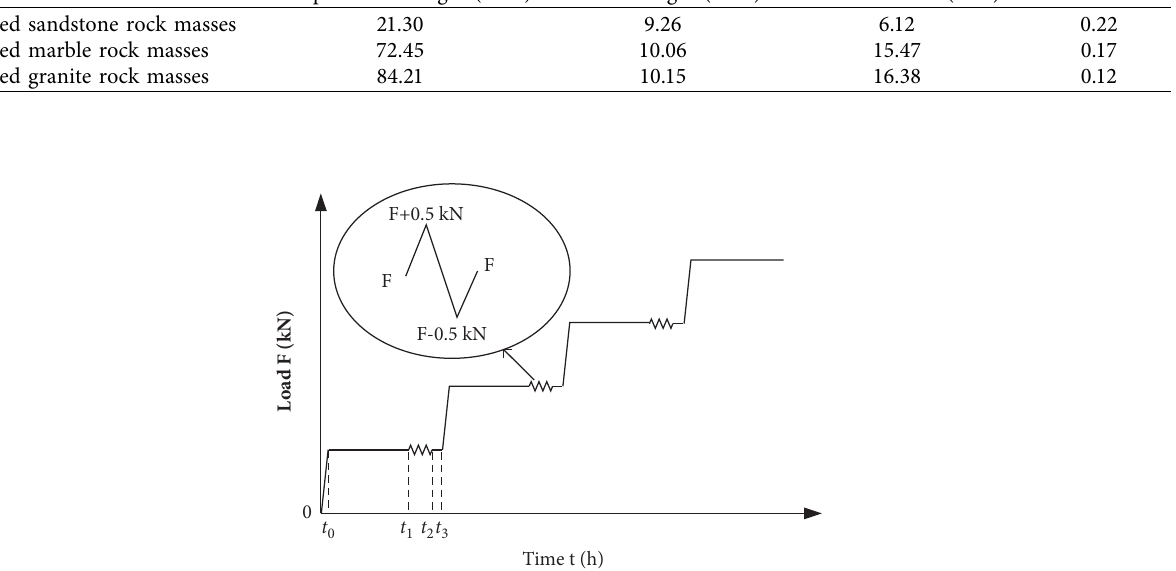
Figure 3: Loading path diagram. 0 − t 0 is the loading time before reaching the specified load; t 0 t 1 − t 2 is the fatigue load application time; and t 2 − t 3 is the stability time after the fatigue load is